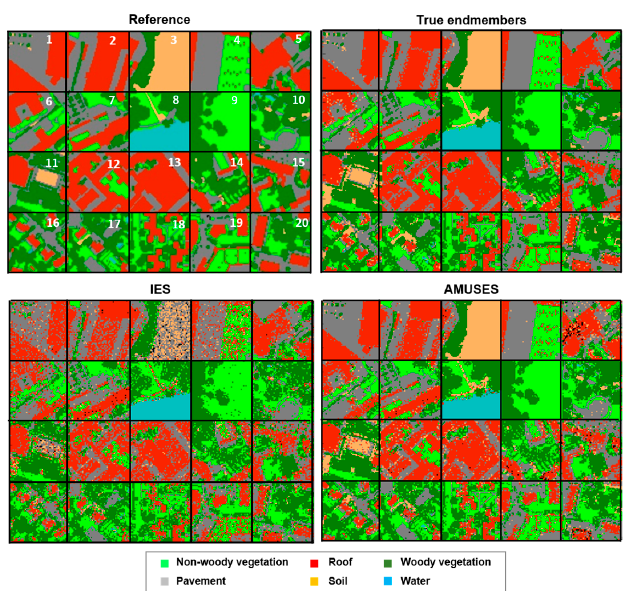
Figure 7. Reference land cover map compared to the different land cover maps produced for the Brussels case study by applying MESMA on different spectral libraries, i.e., the true endmembers present in the image blocks, a library obtained using Iterative Endmember Selection (IES) and one obtained using the newly proposed AMUMSES algorithm. The classification product developed using the true endmembers slightly deviates from the reference data due to the noise introduced in the simulated image and minor modelling errors in the MESMA-based classification